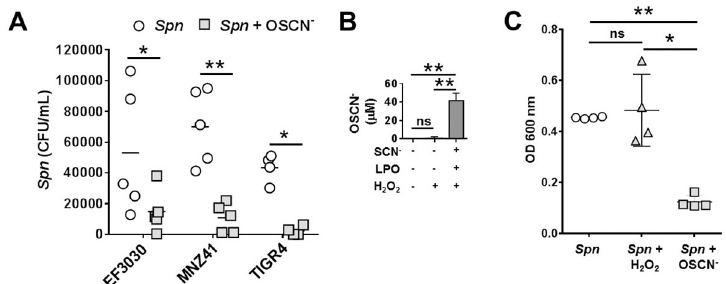
Fig 1. LPO-derived hypothiocyanite kills Spn in vitro . (A) OSCN — mediated Spn killing was tested in the cell-free system against three different bacterial strains: EF3030 encapsulated serotype 19F (n = 5), MNZ41 nonencapsulated (n = 5) and TIGR4 encapsulated serotype 4 (n = 4). Bacteria were incubated for 6 hrs with or without OSCN - generated by the LPO/SCN - /H 2 O 2 system and bacterial killing was quantified by colony counts on BAP. Each dot represents a separate, individual experiment and their mean is also shown, Mann-Whitney test. (B) OSCN - is only produced in the cell-free system when all of its components (LPO, SCN - , H 2 O 2 ) are present. H 2 O 2 is provided by the enzymatic reaction of glucose oxidase with glucose, not in a bolus-like fashion. Mean+/-S.E.M., n = 4, Two-way ANOVA and Sidak’s multiple comparisons test. (C) Spn EF3030 growth is only inhibited by OSCN - and not by H 2 O 2 . OSCN - was generated in presence of the complete cell-free system (LPO+SCN - +glucose/GO) while H 2 O 2 was produced by the glucose/GO system in the absence of LPO and SCN - . Bacterial growth was assessed using the microplate-based growth assay (n = 4). Each symbol represents a separate, individual experiment and their mean+/- S.E.M. is also shown, two- way ANOVA and Sidak’s multiple comparisons test. Each experiment was done in biological triplicates and each biological replicate was tested in technical triplicates. (Ns, not significant; � , p < 0.05; �� , p < 0.01. CFU, colony-forming unit; LPO, lactoperoxidase; OSCN - , hypothiocyanite; SCN - , thiocyanate; Spn , Streptococcus pneumoniae . https://doi.org/10.1371/journal.pone.0236389.g001 also ensuring that neither SCN - nor LPO have an antimicrobial effect alone, independent of OSCN - formation. Results shown in Fig 2B indicate that Spn bacteria exposed to OSCN - have inhibited bacterial growth compared to those treated with catalase or unexposed to OSCN - . Both Spn strains tested show the same trend, where OSCN - treatment significantly reduces bacterial growth (p < 0.0001) and addition of catalase entirely rescues this effect (p < 0.0001)